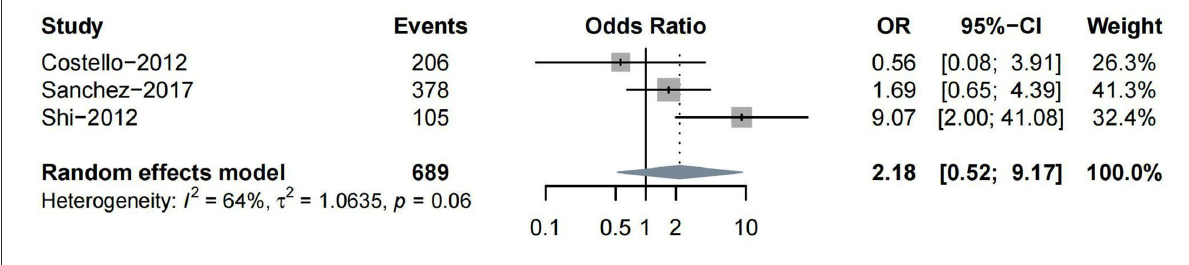
FIGURE4 The severity of WML and the risk of parenchymal hematoma